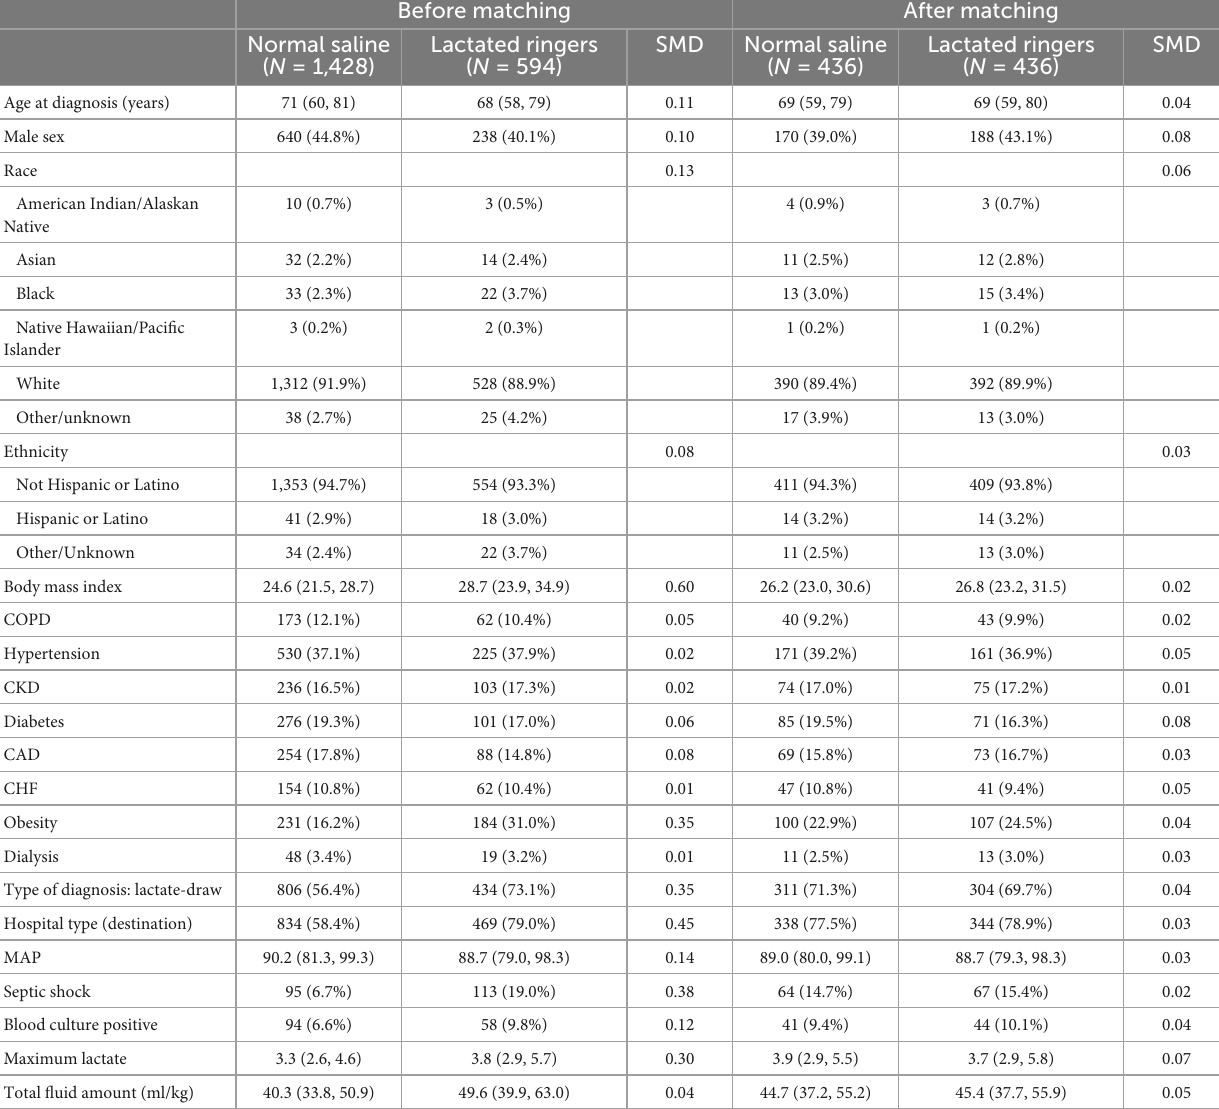
TABLE 1A Baseline characteristics before and after matching according to fluid type among those who received 30 ml/kg or more. Before